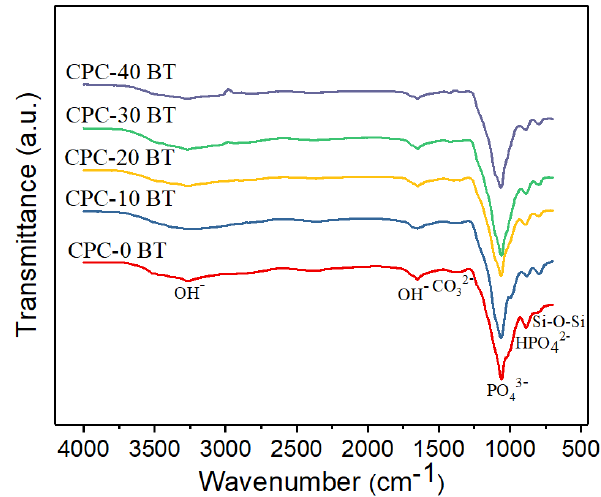
Figure 3. Fourier transform infrared spectroscopy (FTIR) spectra of smart CPC formulation with varying wt % BT.